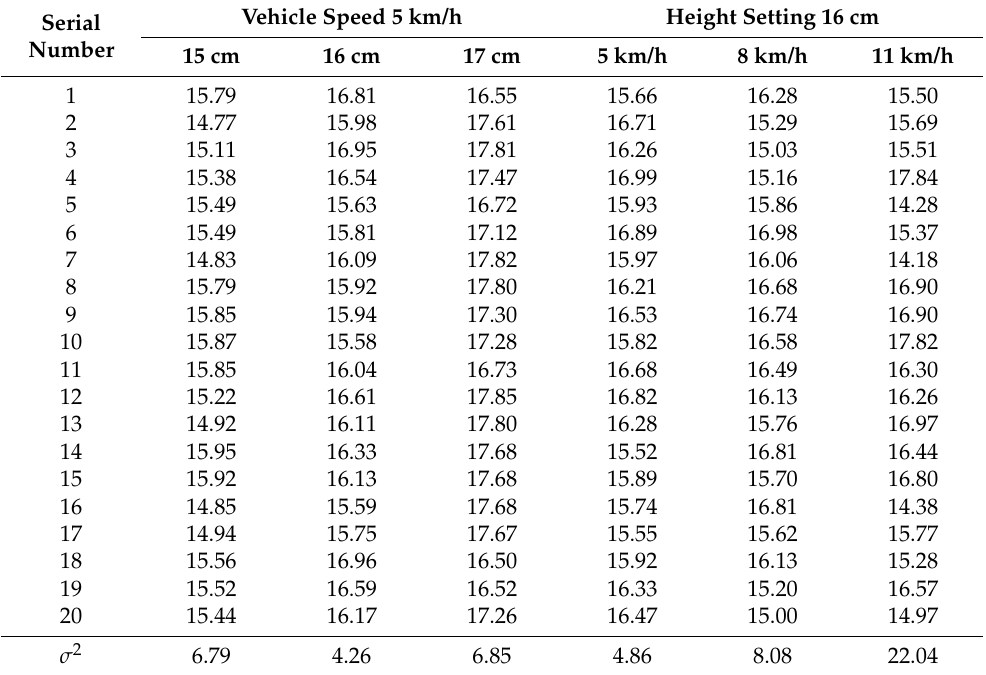
Table 4. Header accuracy test results.